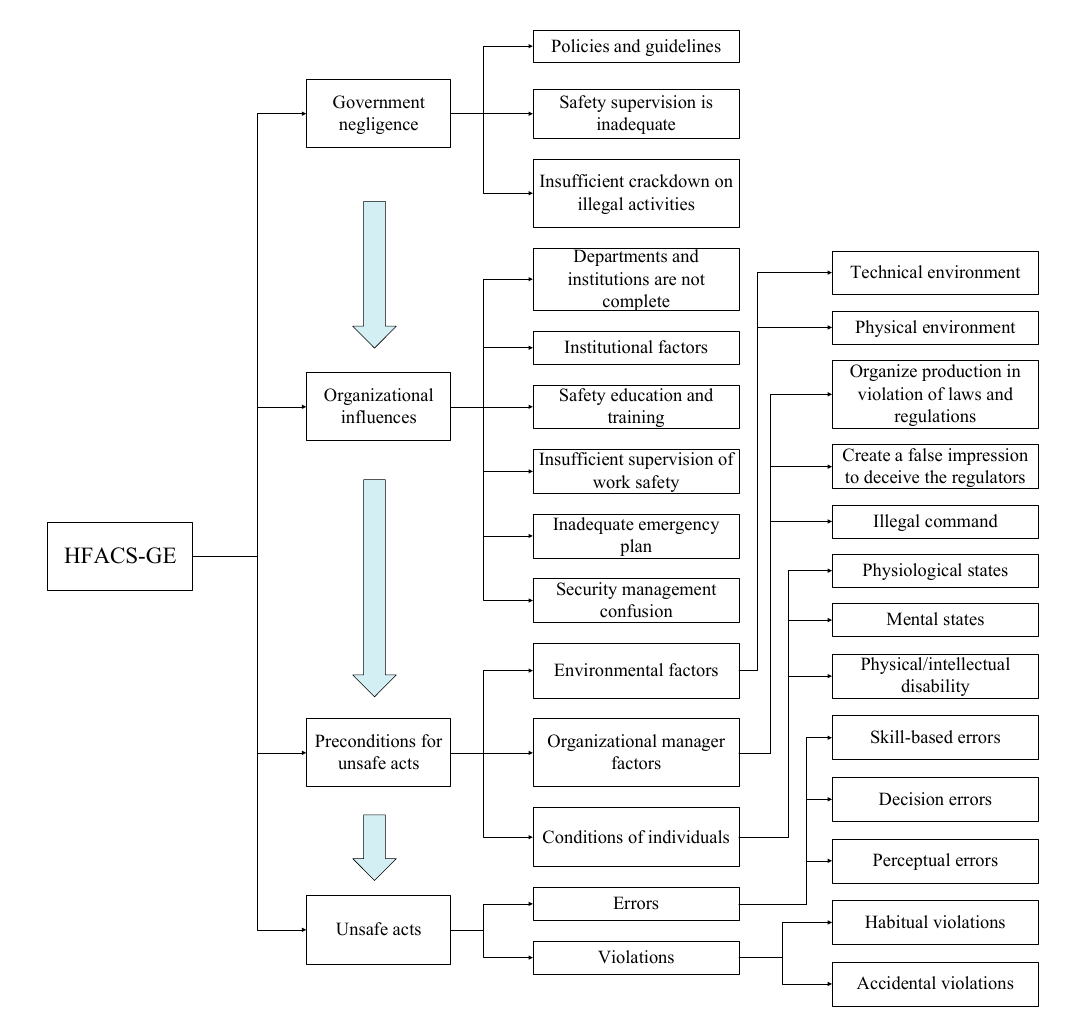
Figure 3. The HFACS-GE framework.